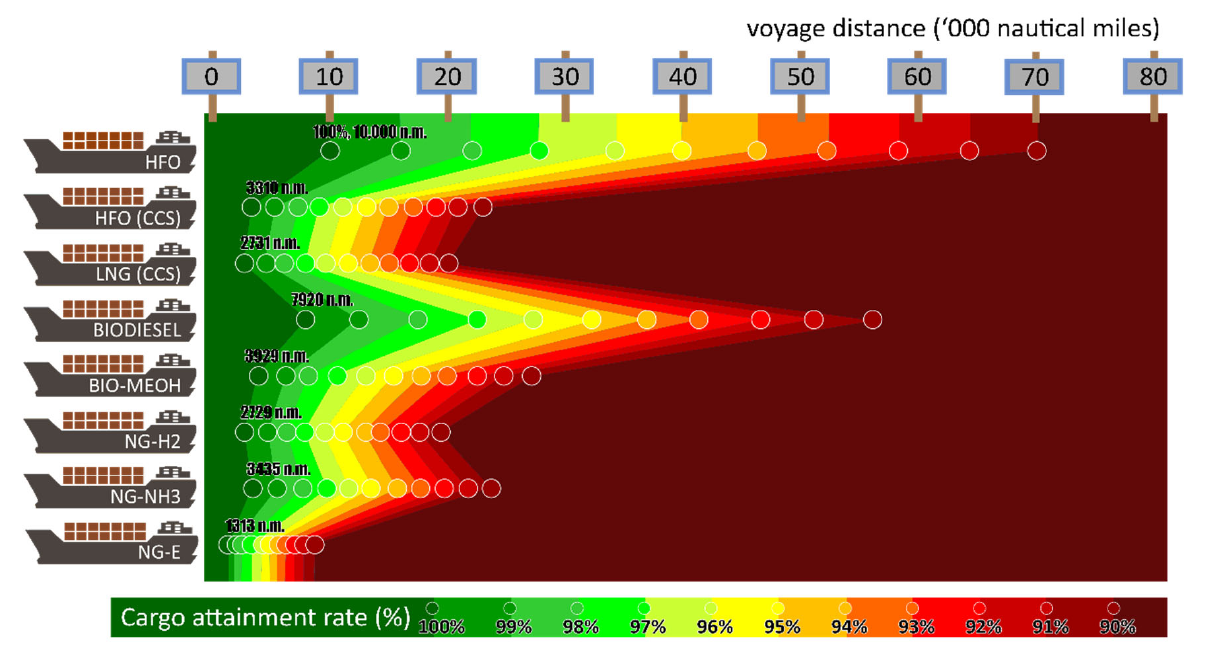
Figure 11. Cargo attainment rate for various alternative fuels against voyage distance, for ships carrying 1.25 m 3 /ton. The reference is an HFO ‐ fuelled containership carrying 1.25 m 3 /ton for 10,000 nm.